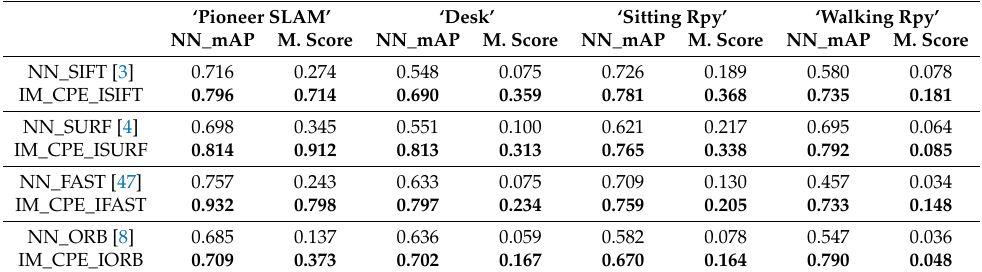
Figure 6. Comparison of proposed IM_CPE and existing NN method using different key points extraction methods in terms of recall v.s. 1 − precision : ( a ) ‘pioneer SLAM’ sequence; ( b ) ‘desk’ sequence; ( c ) ‘sitting rpy’ sequence; and ( d ) ‘walking rpy’ sequence. Table 5. Comparison of proposed IM_CPE and existing NN method using different key points extraction methods in terms of NN_mAP and